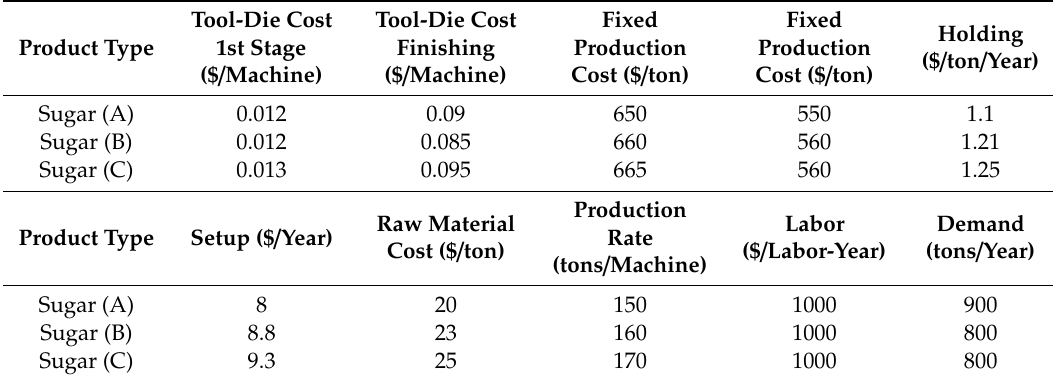
Table 2. Agri-processing firm data for processing various sugar grades from